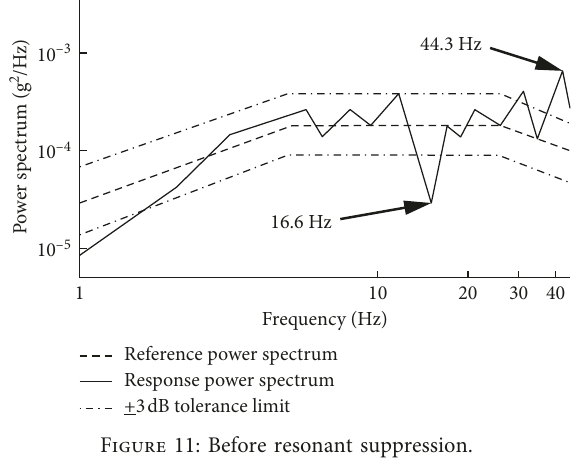
Figure 11: Before resonant suppression.